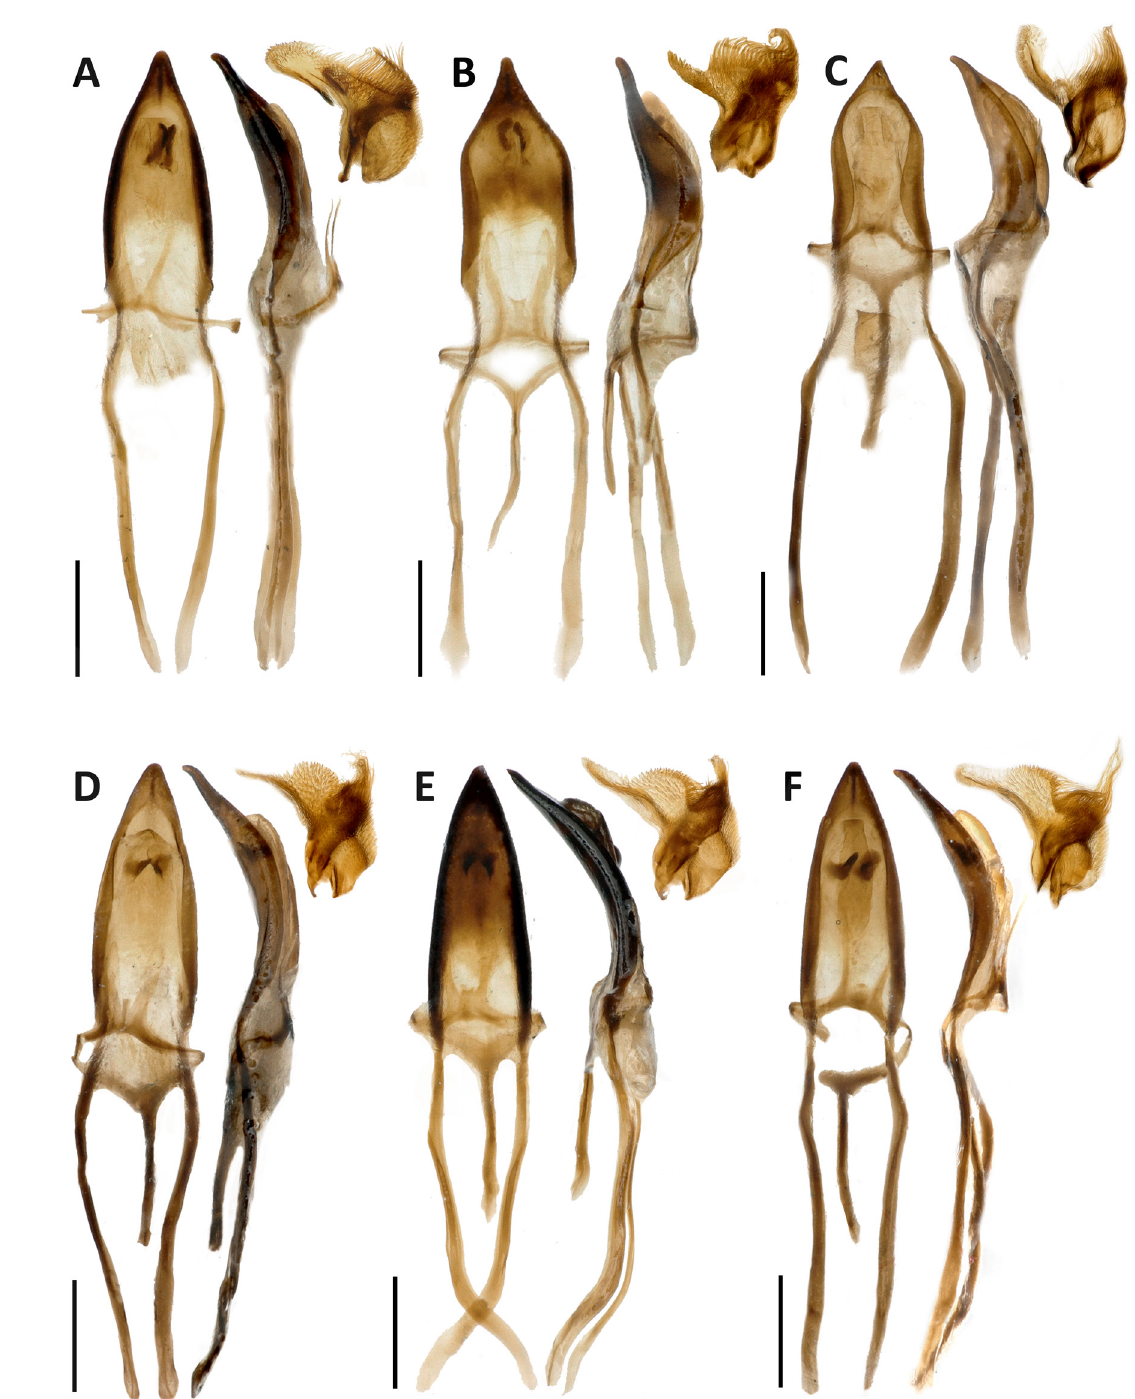
Fig. 2. Penis of Phlyctinus Schoenherr, 1826, in dorsal (left) and lateral (right) view, and copulatory sclerite (top right). A . P. callosus (Schoenherr, 1826). B . P. grootbosensis Haran sp. nov. C . P. xerophilus Haran sp. nov., holotype ♂. D . P. planithorax Haran sp. nov., holotype ♂. E . P. littoralis Haran sp. nov., holotype ♂. F . P. aloevorus Haran sp. nov., holotype ♂. Scale bars = 500 µm. Copulatory sclerite not to